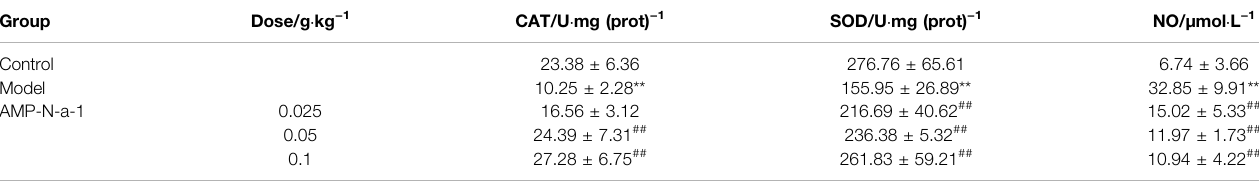
TABLE 2 | Effects of AMP-N-a-1 on the oxidative stress – related enzymes in the brain tissue of mice with learning and memory disorders ( n = 18, mean ± s). Group